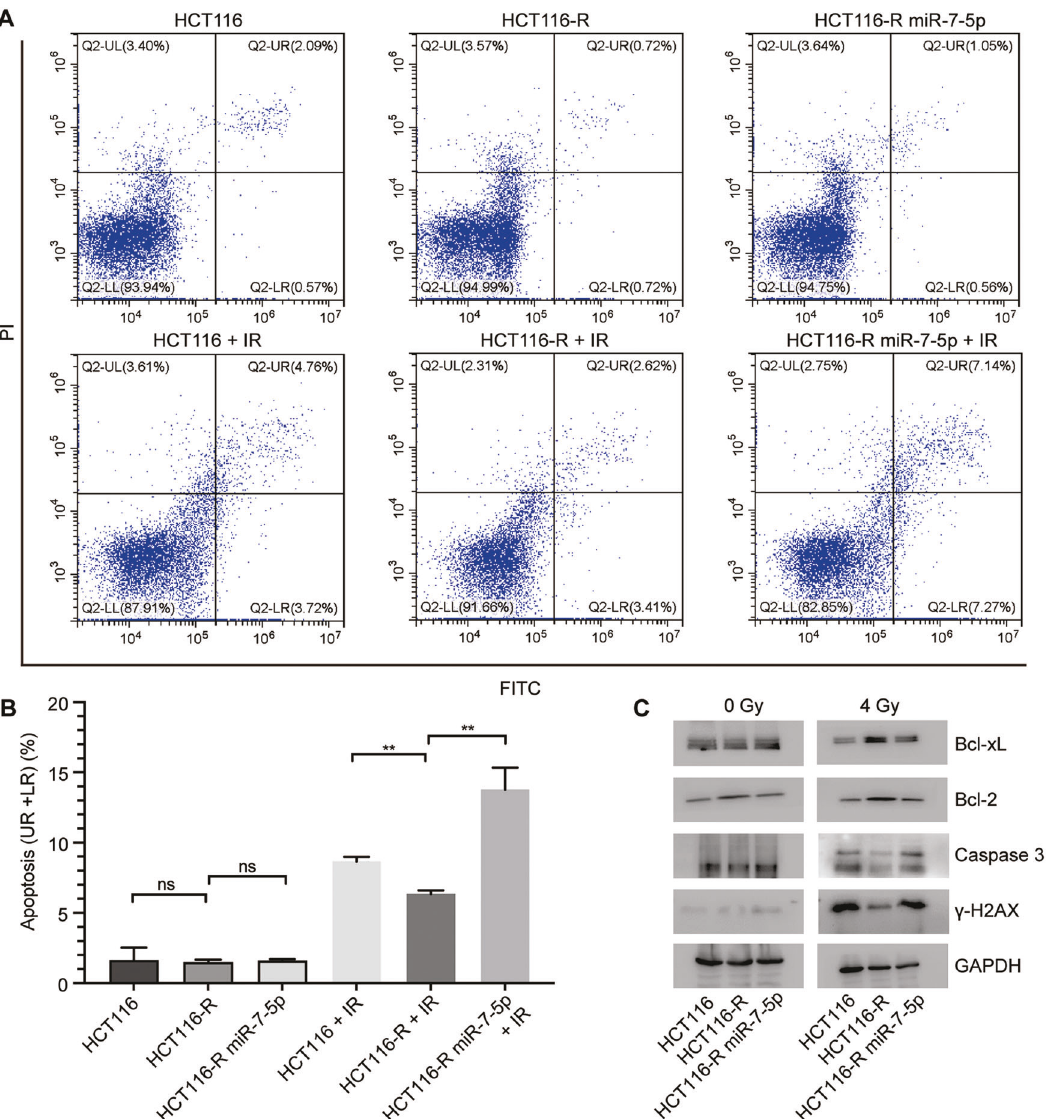
Fig. 2 MiR-7-5p promoted the irradiation-induced apoptosis in CRC cells. A Representative images of apoptosis in HCT116, HCT116-R and miR-7-5p-overexpressing HCT116-R cells in 48 h after treatment with 0 or 4 Gy irradiation. B The early and late apoptotic cell rates (UR + LR) were quanti fi ed. C Western blot assays showed the expression changes of apoptosis-related genes, including Bcl-xL, Bcl-2 and caspase 3, and a DNA-damage marker γ -H2AX in HCT116, HCT116-R and miR-7-5p-overexpressing HCT116-R cells after 0 or 4 Gy irradiation treatment. UL upper left quadrant, UR upper right quadrant, LL lower left quadrant, LR lower right quadrant, Data are presented as mean ± SD, IR irradiation (4 Gy); ns no signi fi cant difference, ** P <